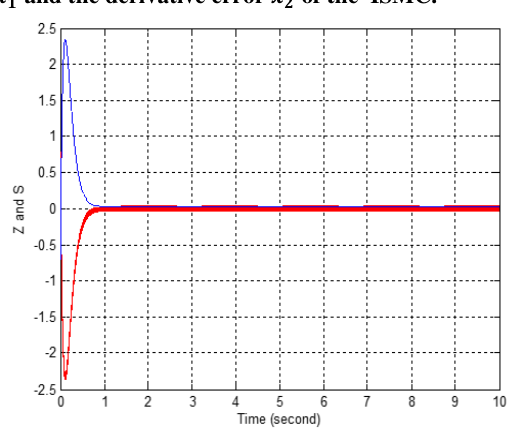
Fig. 21. The plot of phase plane between the error The plot of phase plane between the error of the ISMC. _ ‘ and the derivative error _ b of the ISMC.